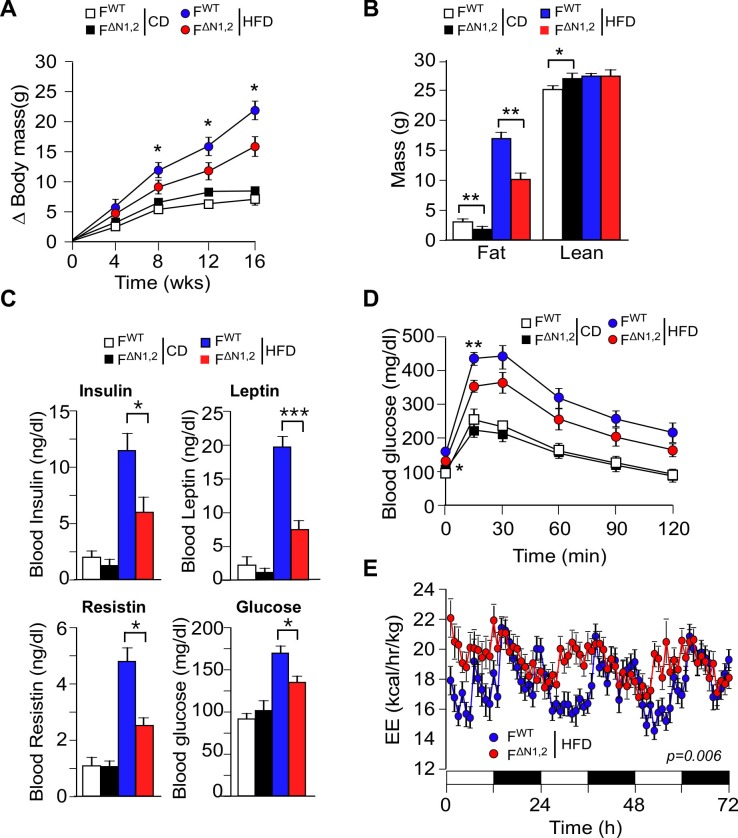
NOVA promotes the development of diet-induced obesity.(A) The change in body mass of FWT and F∆N1,2 mice fed a CD or a HFD is presented (mean ± SEM; n=8~30; *p<0.05). (B) Body composition was examined by proton magnetic resonance spectroscopy (mean ± SEM; n=8~22; *p<0.05; **p<0.01). The source data are included as Figure 4—source data 1. (C) Blood insulin, leptin, resistin, and glucose in overnight starved CD-fed and HFD-fed (12 wks) FWT and F∆N1,2 mice were measured (mean ± SEM; n=8~16; *p<0.05; ***p<0.001). The source data are included as Figure 4—source data 2. (D) CD-fed and HFD-fed (12 wks) FWT and F∆N1,2 mice were examined by glucose tolerance tests (mean ± SEM; n=8~26; *p<0.05; ***p<0.001). The source data are included as Figure 4—source data 3. (E) Energy expenditure (EE) by HFD-fed (4 wks) FWT mice (n = 9) and F∆N1,2 mice (n = 8) was examined using metabolic cages over 3 days (12 hr light; 12 hr dark). The source data are included as Figure 4—source data 4.DOI:
http://dx.doi.org/10.7554/eLife.17672.02110.7554/eLife.17672.022Figure 4—source data 1.Source data for Figure 4B.DOI:
http://dx.doi.org/10.7554/eLife.17672.02210.7554/eLife.17672.023Figure 4—source data 2.Source data for Figure 4C.DOI:
http://dx.doi.org/10.7554/eLife.17672.02310.7554/eLife.17672.024Figure 4—source data 3.Source data for Figure 4D.DOI:
http://dx.doi.org/10.7554/eLife.17672.02410.7554/eLife.17672.025Figure 4—source data 4.Source data for Figure 4E.